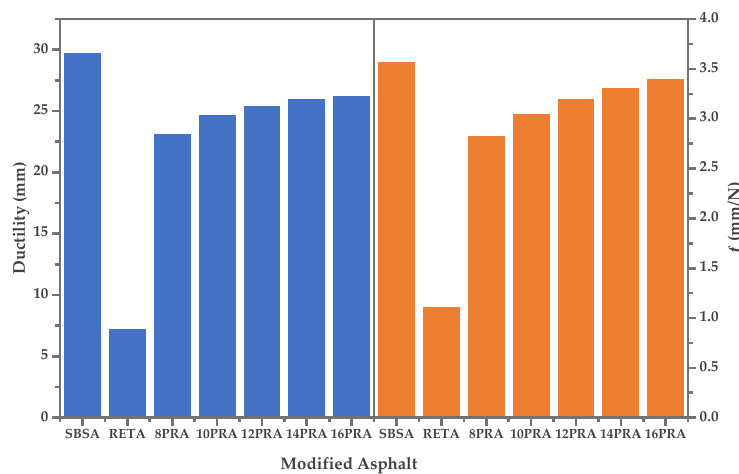
Figure 3. The force ductility test results of modified asphalts.